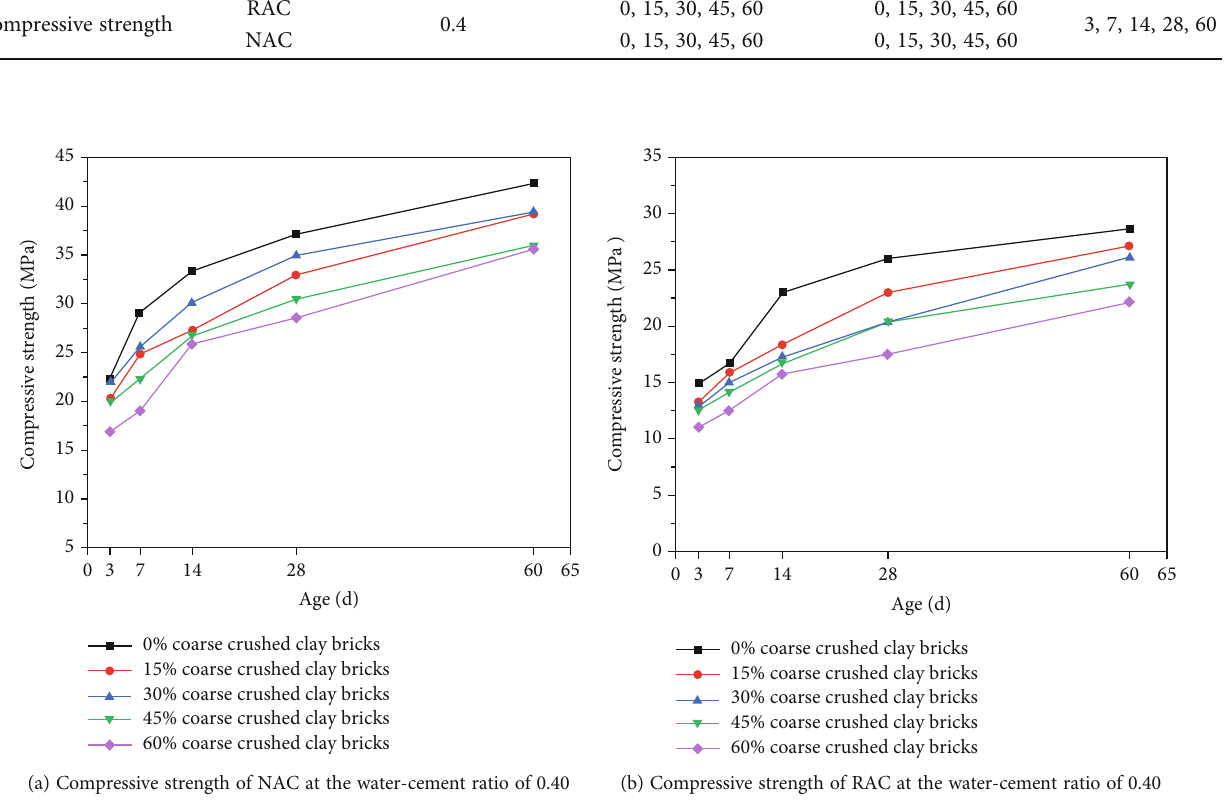
Figure 3: The compressive strength of NAC and RAC with di ff erent coarse crushed clay brick